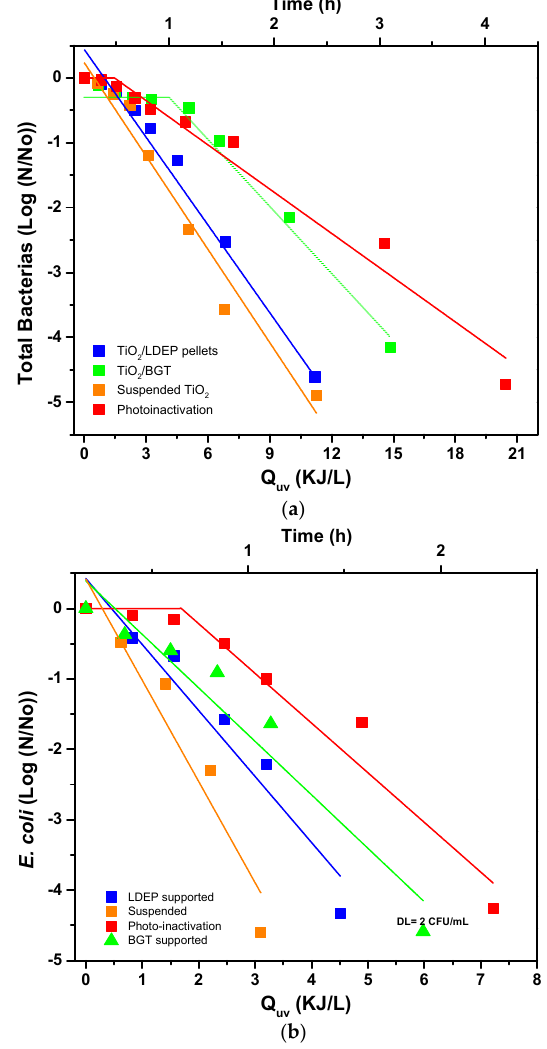
Figure 8. Inactivation of 10 5 CFU/mL of ( a ) total bacteria and ( b ) E. coli with suspended TiO 2 , TiO 2 /SiO 2 ‐ BGT, and TiO 2 ‐ LDPE pellets.